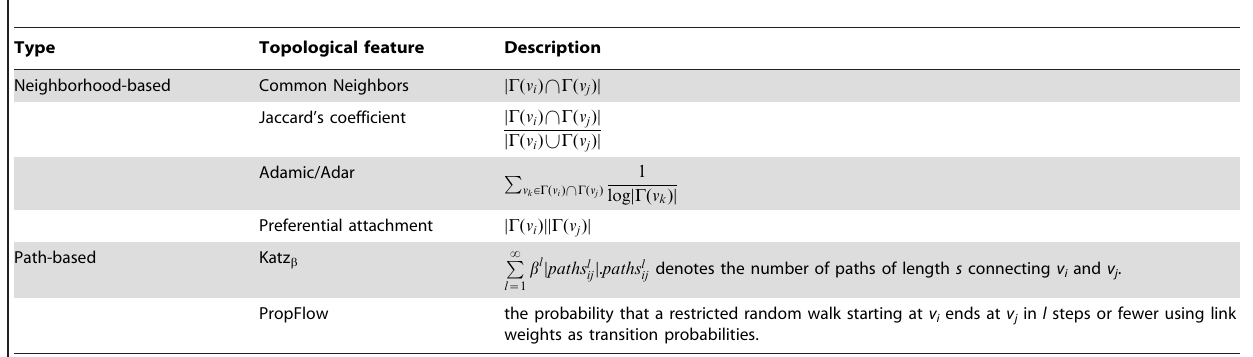
Table 1. Formula for the 6 topological features used in this